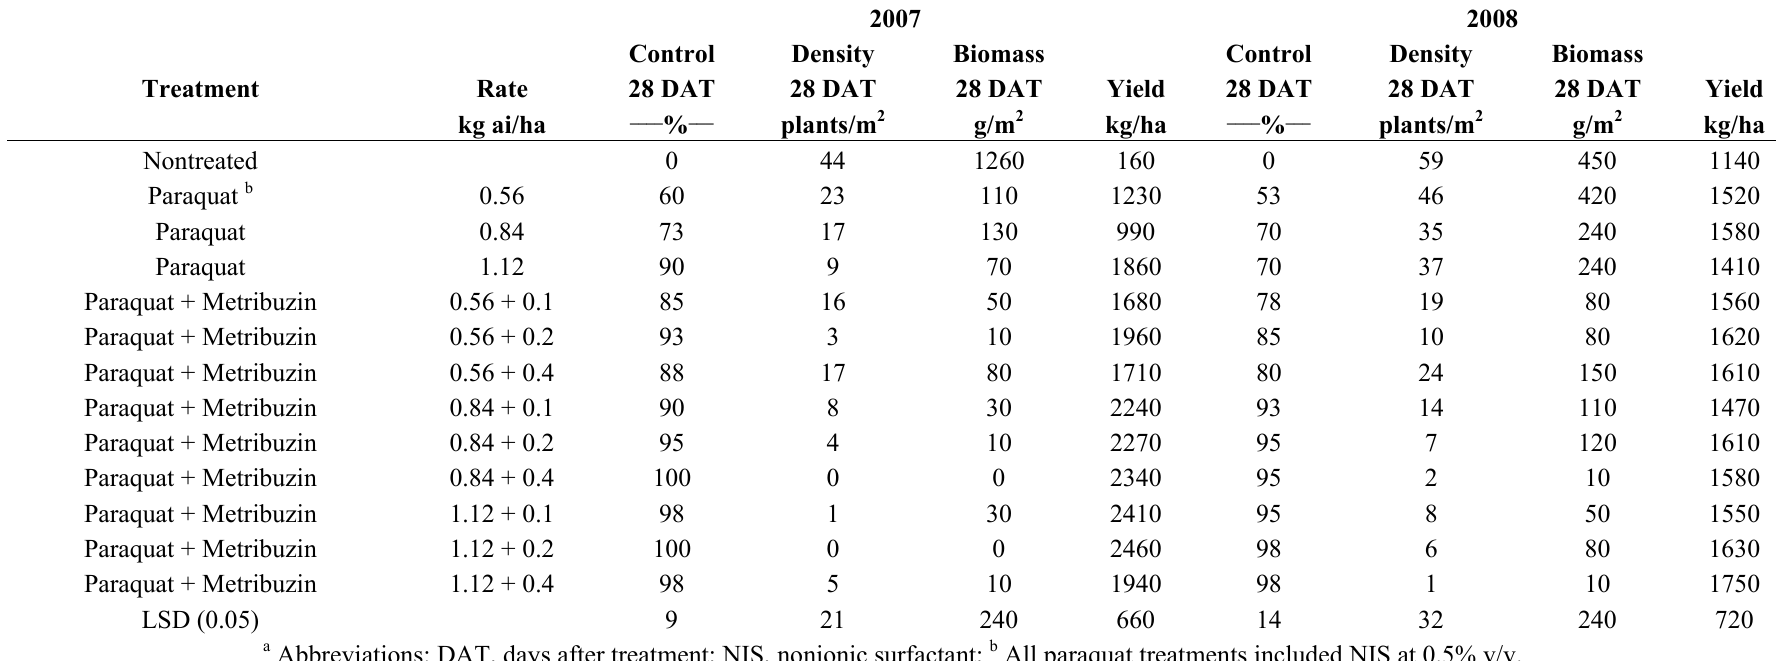
Table 2. Horseweed (15-cm) control, plant density, and biomass 28 day after treatment, and soybean yield in Stoneville, Mississippi a . 2007 2008 Control Density Biomass Control Density Biomass Treatment Rate 28 DAT 28 DAT 28 DAT Yield kg ai/ha plants/m 2 Nontreated Paraquat b Paraquat Paraquat Paraquat + Metribuzin Paraquat + Metribuzin 0.56 + 0.2 Paraquat + Metribuzin 0.56 + 0.4 Paraquat + Metribuzin 0.84 + 0.1 Paraquat + Metribuzin 0.84 + 0.2 Paraquat + Metribuzin Paraquat + Metribuzin 1.12 + 0.1 Paraquat + Metribuzin Paraquat +